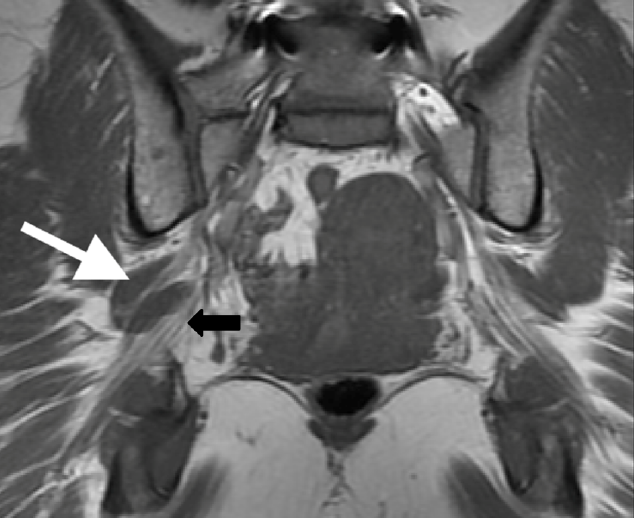
Figure 3. Coronal T1-weighted sequence of the bilateral sciatic nerves showing a type II variant with a common peroneal nerve component piercing a bifid piriformis (white arrow), tibial nerve component running in normal position anterior and inferior to piriformis (black arrow).